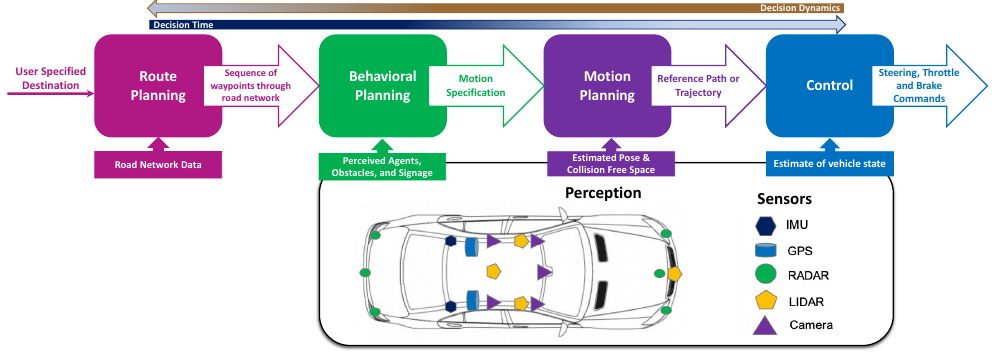
Figure 2. Software Architecture of Autonomous